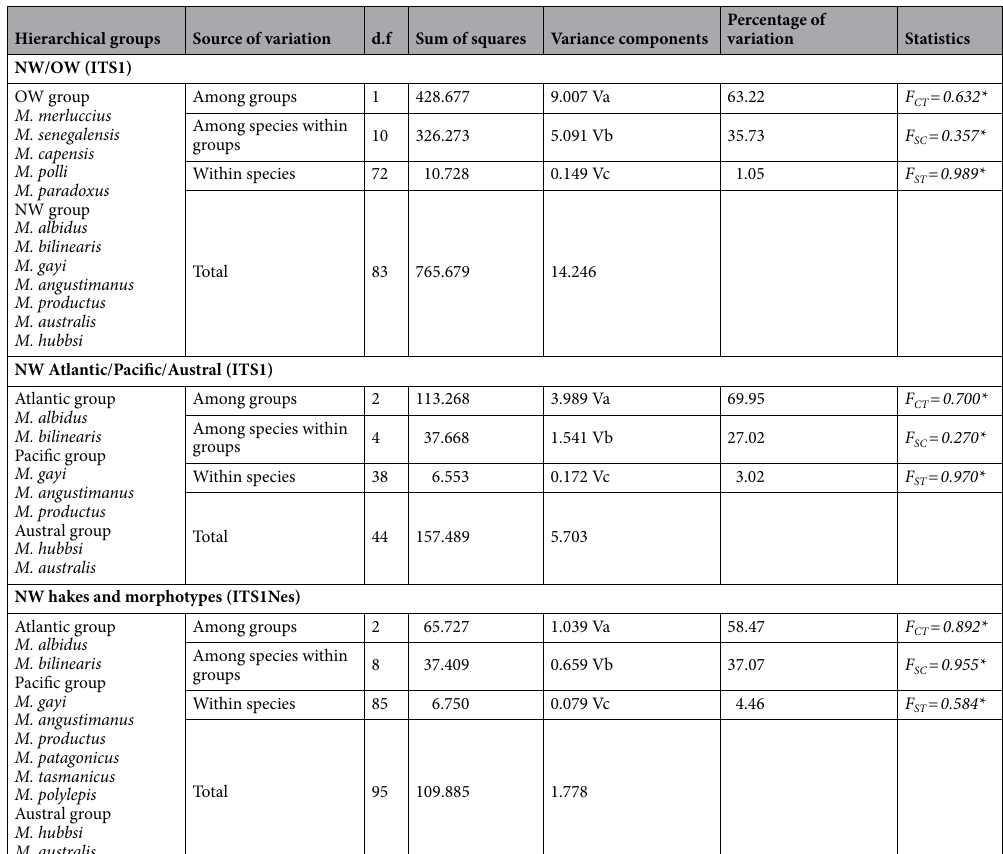
Table 5. Analysis of Molecular Variance (AMOVA) after Arlequin v3.5.2.2 79 on the hierarchical levels showing the highest partition values among groups of species: NW (New World)/OW (Old World) hakes using ITS1 variants; NW hakes (Atlantic/Pacific/Austral) using ITS1 variants; NW hakes and hake morphotypes using ITS1Nes variants. F -statistics were used to estimate the proportion of genetic variation found among species ( F ST ), among species within groups ( F SC ) and among groups ( F CT ); *p < 0.001.